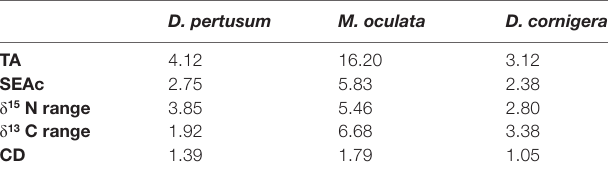
TABLE 3 | Total area (TA, ‰ 2 ), Standard ellipse area (SEA C, ‰ 2 ) and Layman metrics calculated for each